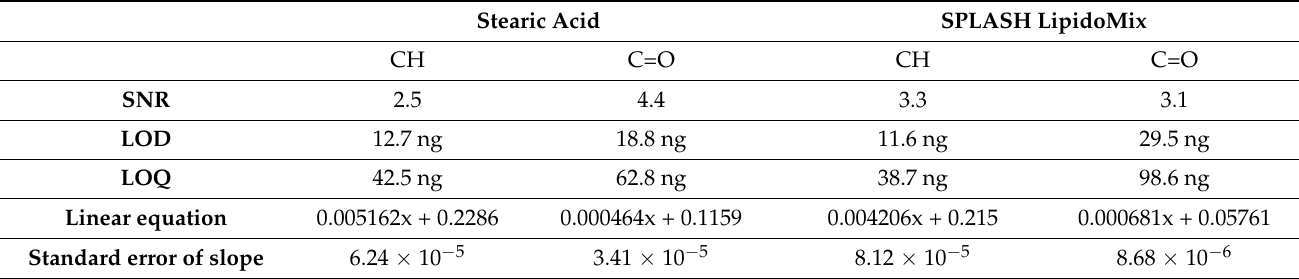
Table 1. Characteristics of two different ATR-FTIR lipid calibration